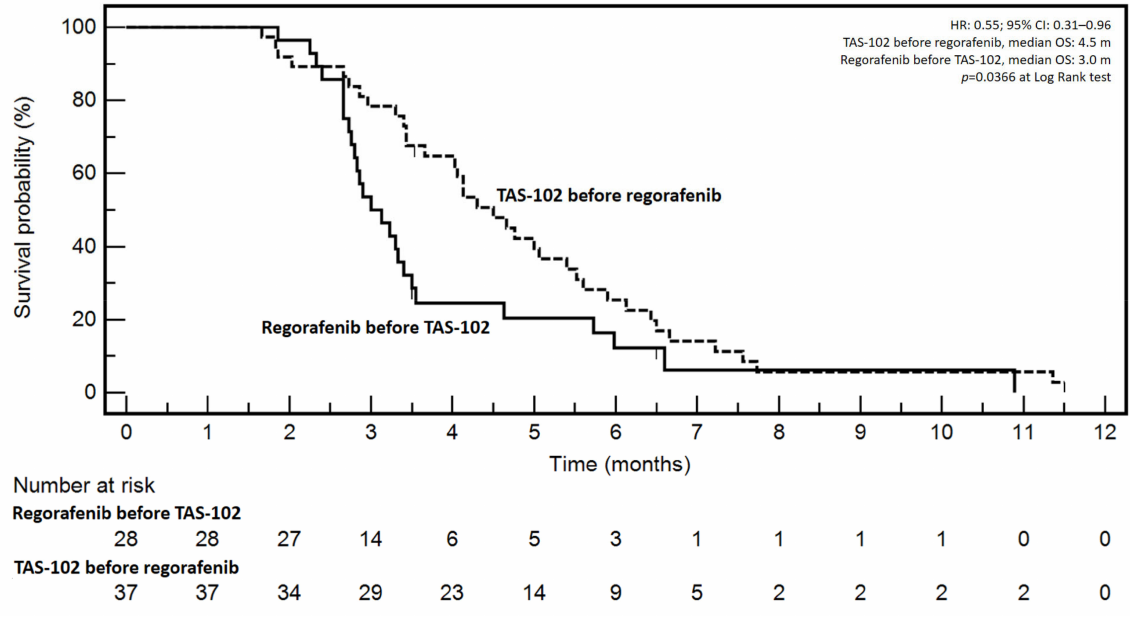
Figure 1. Kaplan–Meyer survival curves according to different sequences therapy.